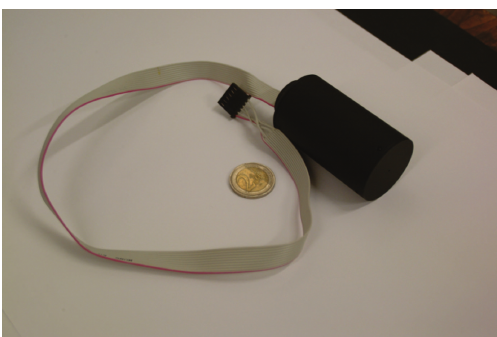
Figure 2: Example of sun finder with 1